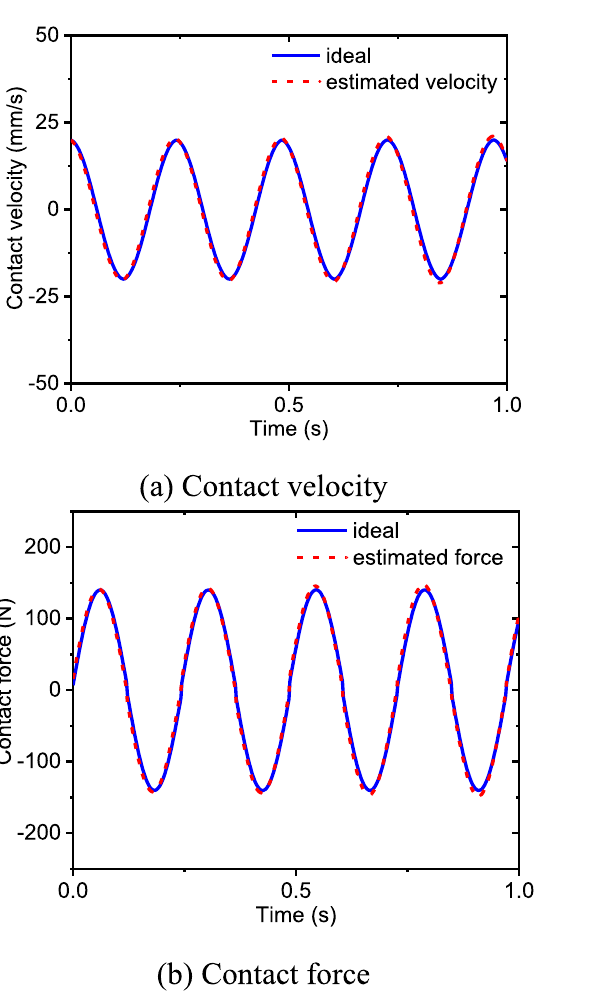
Figure 7 Contact velocities and forces in co-simulation